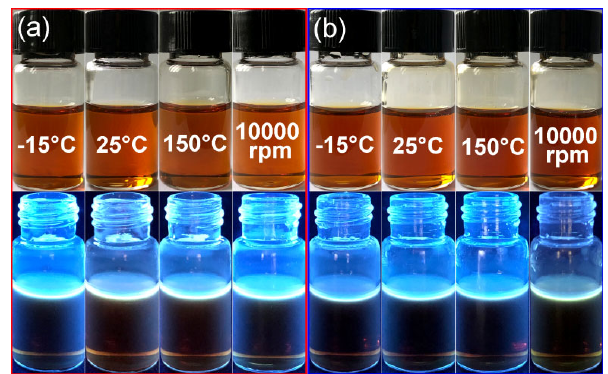
Fig. 7 Optical photos of (a) A-g-CNPs and (b) C-g-CNPs dispersions in PEG200 (0.7 wt%) standing for 1 month at − 15, 25, and 150 °C or centrifuging (10,000 rpm) for half an hour under the room light (upper) and UV irradiation (365 nm) (bottom).